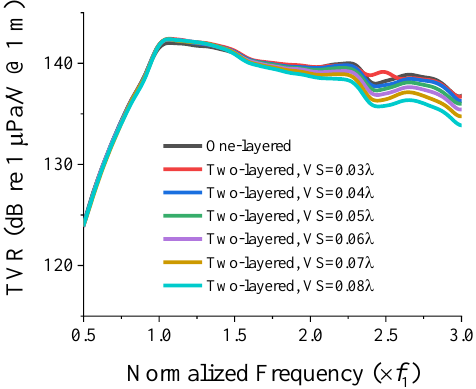
Figure 4. TVR spectra of the 3 × 3 cymbal array arranged in one-layered and two-layered structures with CTC spacing of 0.23 𝜆 , and vertical spacing (VS) from 0.03 𝜆 to 0.08 𝜆 . Table 2. Acoustic characteristics of the 3 × 3 cymbal array vs. vertical spacing. Center Vertical Spacing Vertical Spacing